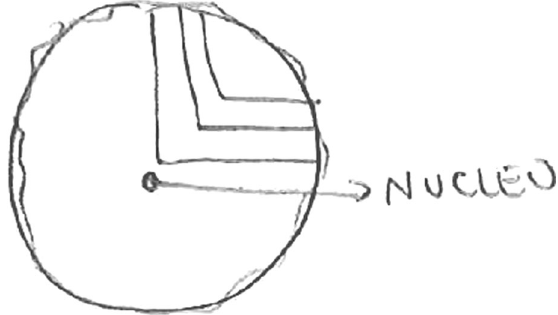
FIG. 10. Sample 2 student sketch of a star ’ s internal structure. Translation of Italian label: nucleus.